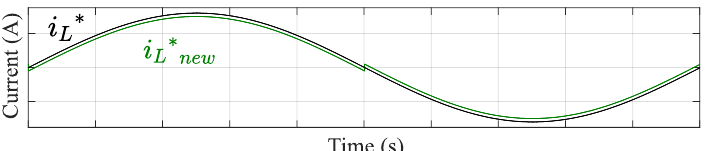
Figure 9. Sinusoidal reference and the reference corrected by fixed